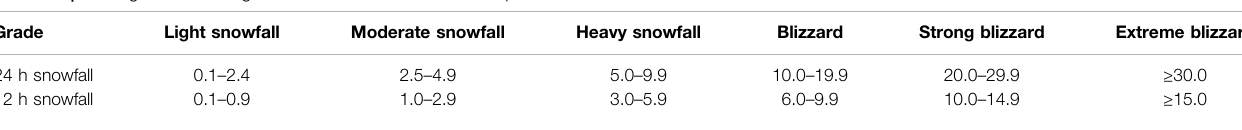
TABLE 2 | Snow grade according to the national standard of “ Precipitation Grades.